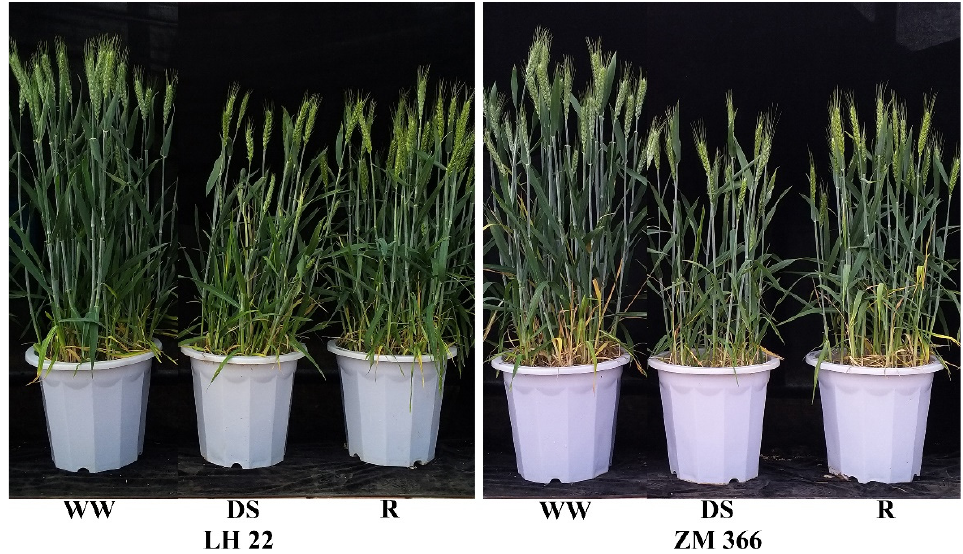
Figure 1. The phenotypes of LH22 (drought − tolerant cultivar) and ZM366 (drought − sensitive cultivar) under drought and re-watering. WW: Well − watered; DS: Drought stress; and R: Re − watering. Table 1. Effects of different treatments on grain yields of wheat.